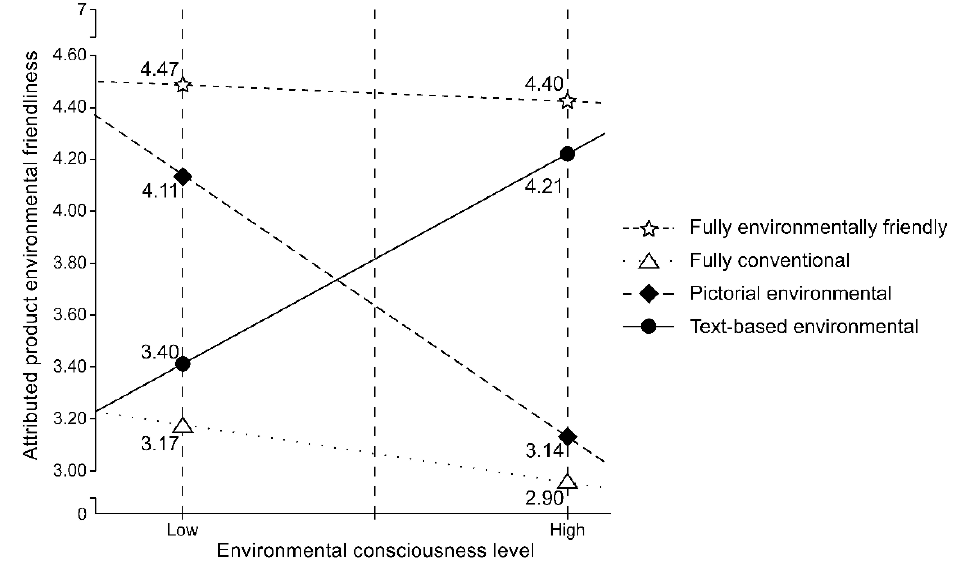
Figure 5. Effect of packaging design and environmental consciousness on attributed product Figure 5. E ff ect of packaging design and environmental consciousness on attributed product environmental friendliness. environmental